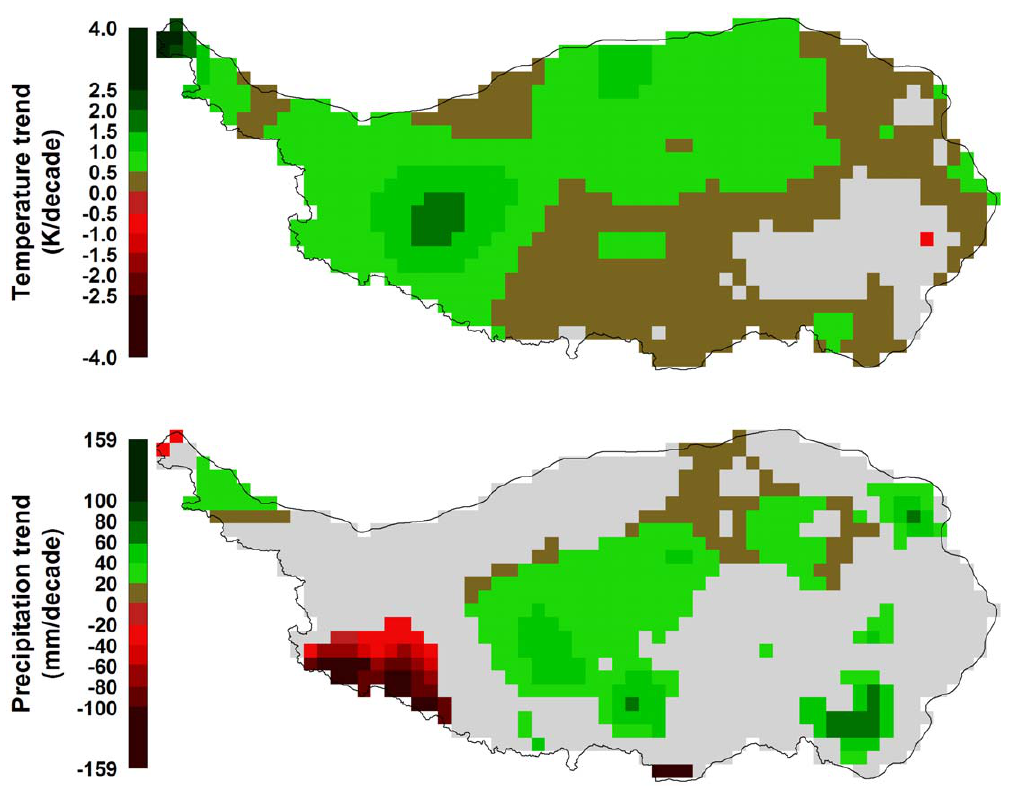
Figure 5. Trends in annual mean temperature (top) and total annual precipitation (bottom) on the Tibetan Plateau between 1982 and 2006. Gray areas indicate regions, for which no significant trends were detected by the Mann-Kendall test at p , 0.1.